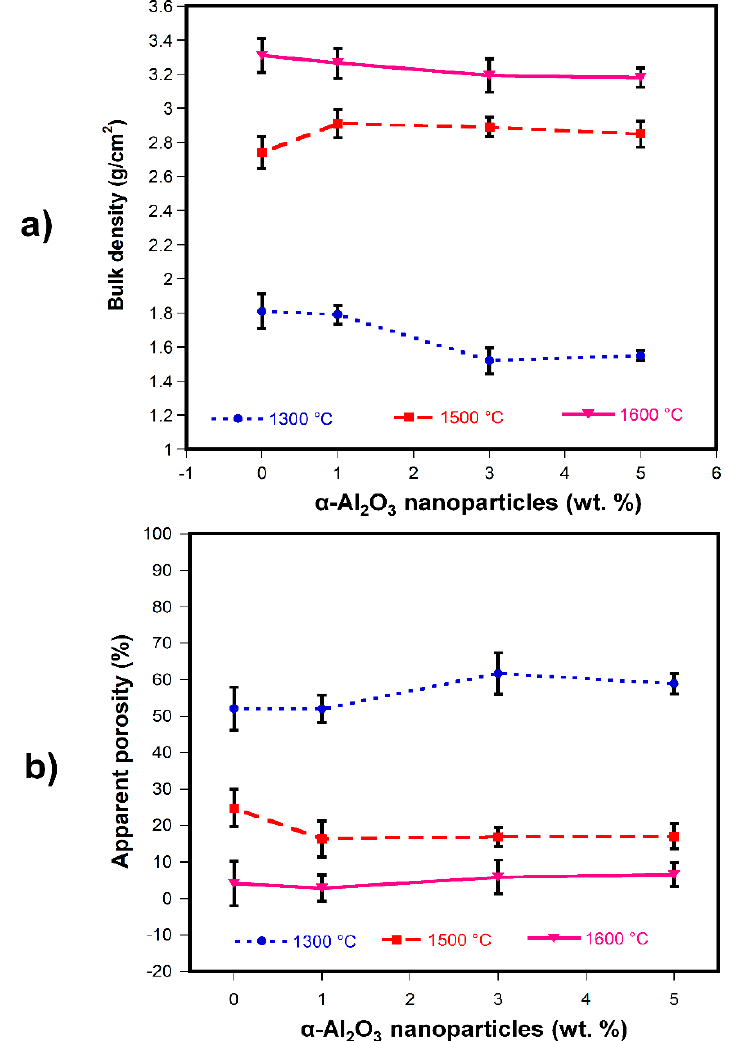
Figure 3. ( a ) Variation of the bulk density and ( b ) variation of the apparent porosity of refractory magnesia as a function of the content of α -Al 2 O 3 nanoparticles.